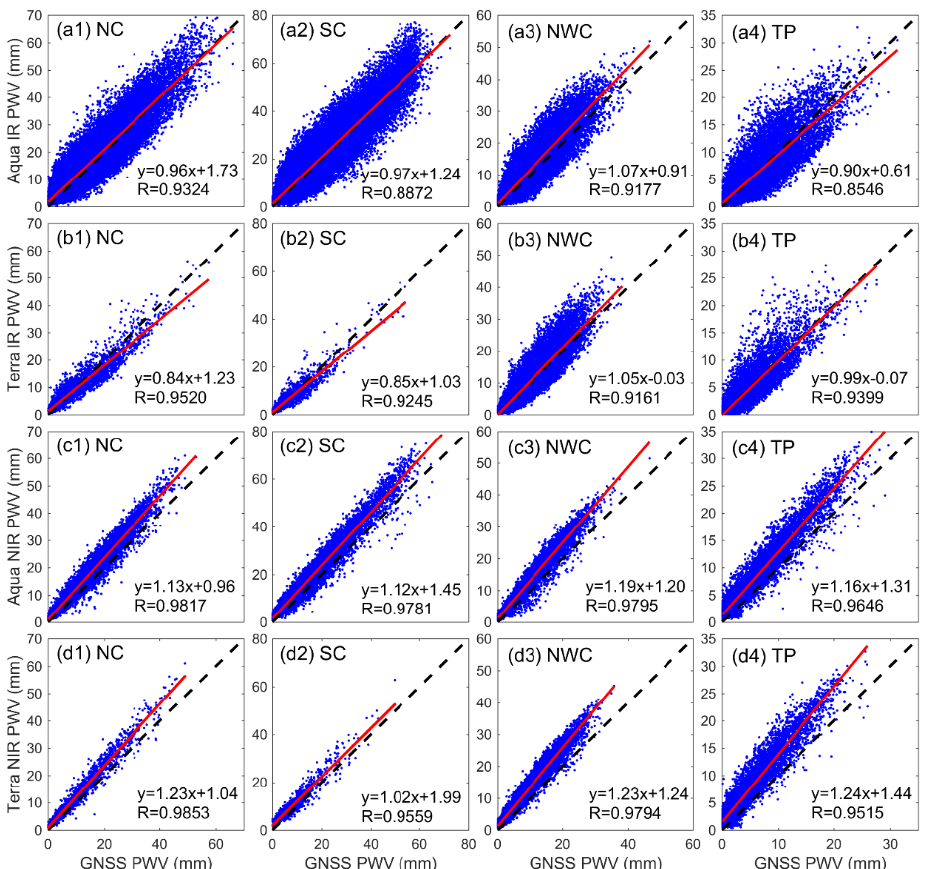
Figure 4. Scatterplots of GNSS-derived versus MODIS-derived IR/NIR PWV values over the period of 2000 – 2015 in the four areas in China, where ( a1 – b4 ) are the comparison of MODIS IR and GNSS PWV, and ( c1 – d4 ) are the comparison of MODIS NIR and GNSS PWV.